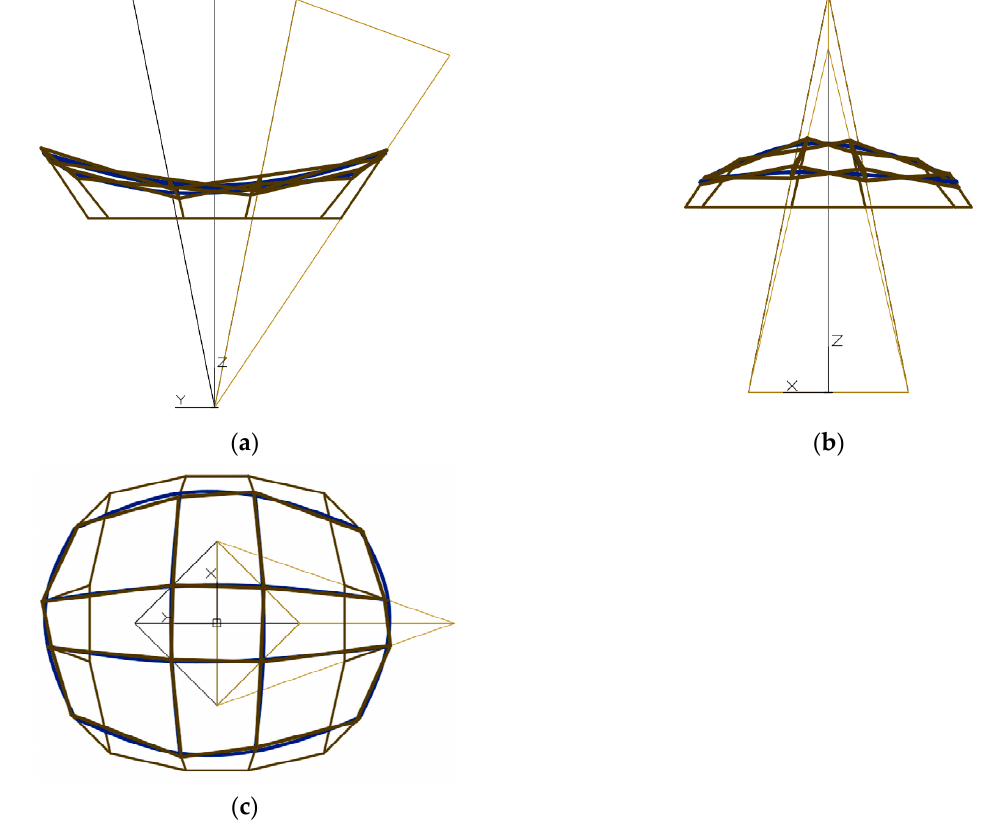
Figure 12. The designed reference network Γ , the third eaves network B v , and the third complex building structure Σ : ( a ) the front view, ( b ) the back view, ( c ) the top view.